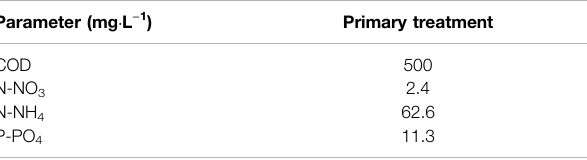
TABLE 1 | Composition of the wastewaters used for the